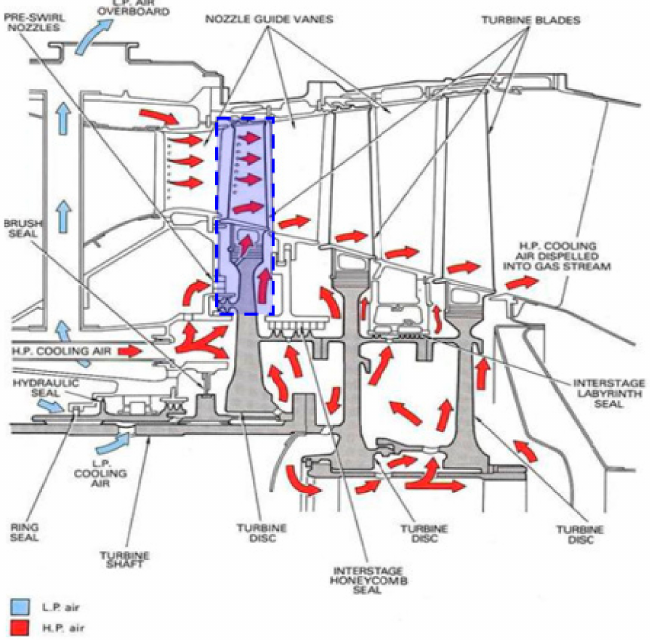
Figure 1. Flow paths in a high-pressure turbine stage [Source: The Jet Engine, 1986].